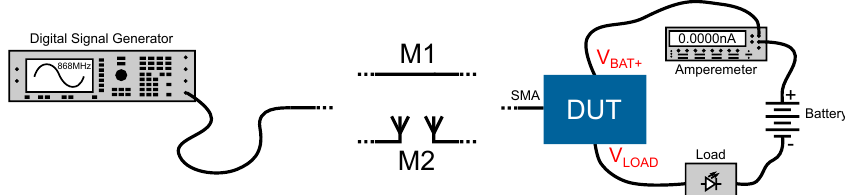
Figure 5. Schematic representation of the measurement setups. A signal generator generates an 868 MHz CW signal for the DUT. In the first setup (M1), the signal is transmitted via cable, in the second one (M2) via antennas.